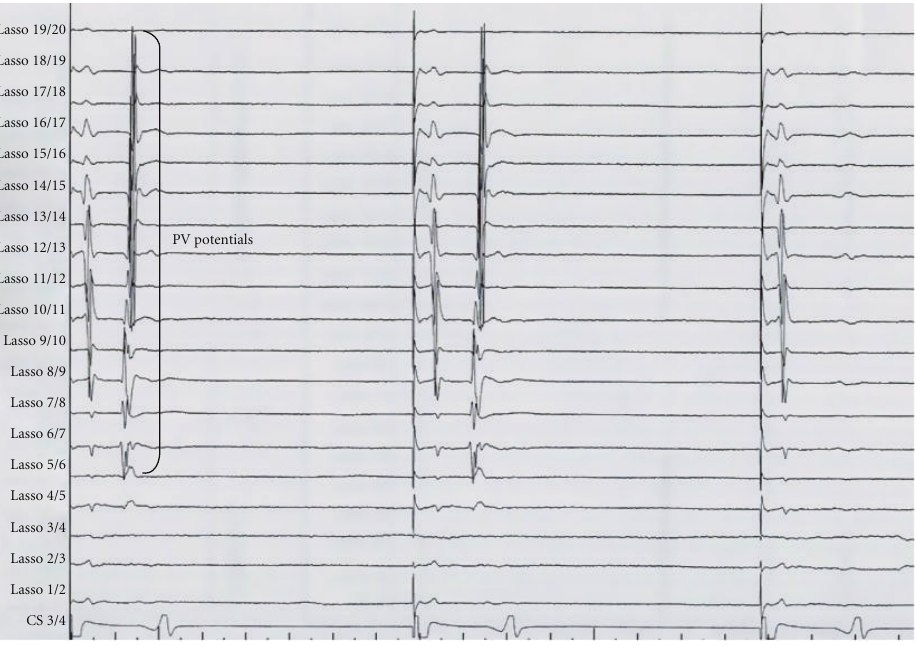
Figure 2: Pulmonary vein (PV) potentials recorded from the Lasso catheter bipoles during pacing from the coronary sinus (CS 3/4). In this example, the PV potentials are disappeared in the third-paced beat indicating entrance block.